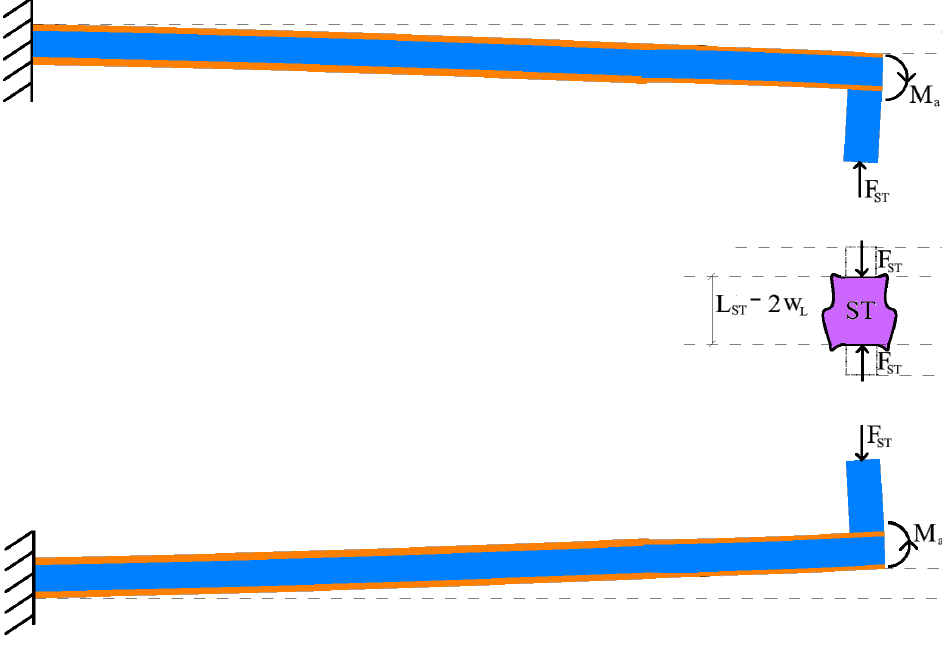
Figure 5. Scheme for the calculation of the tip